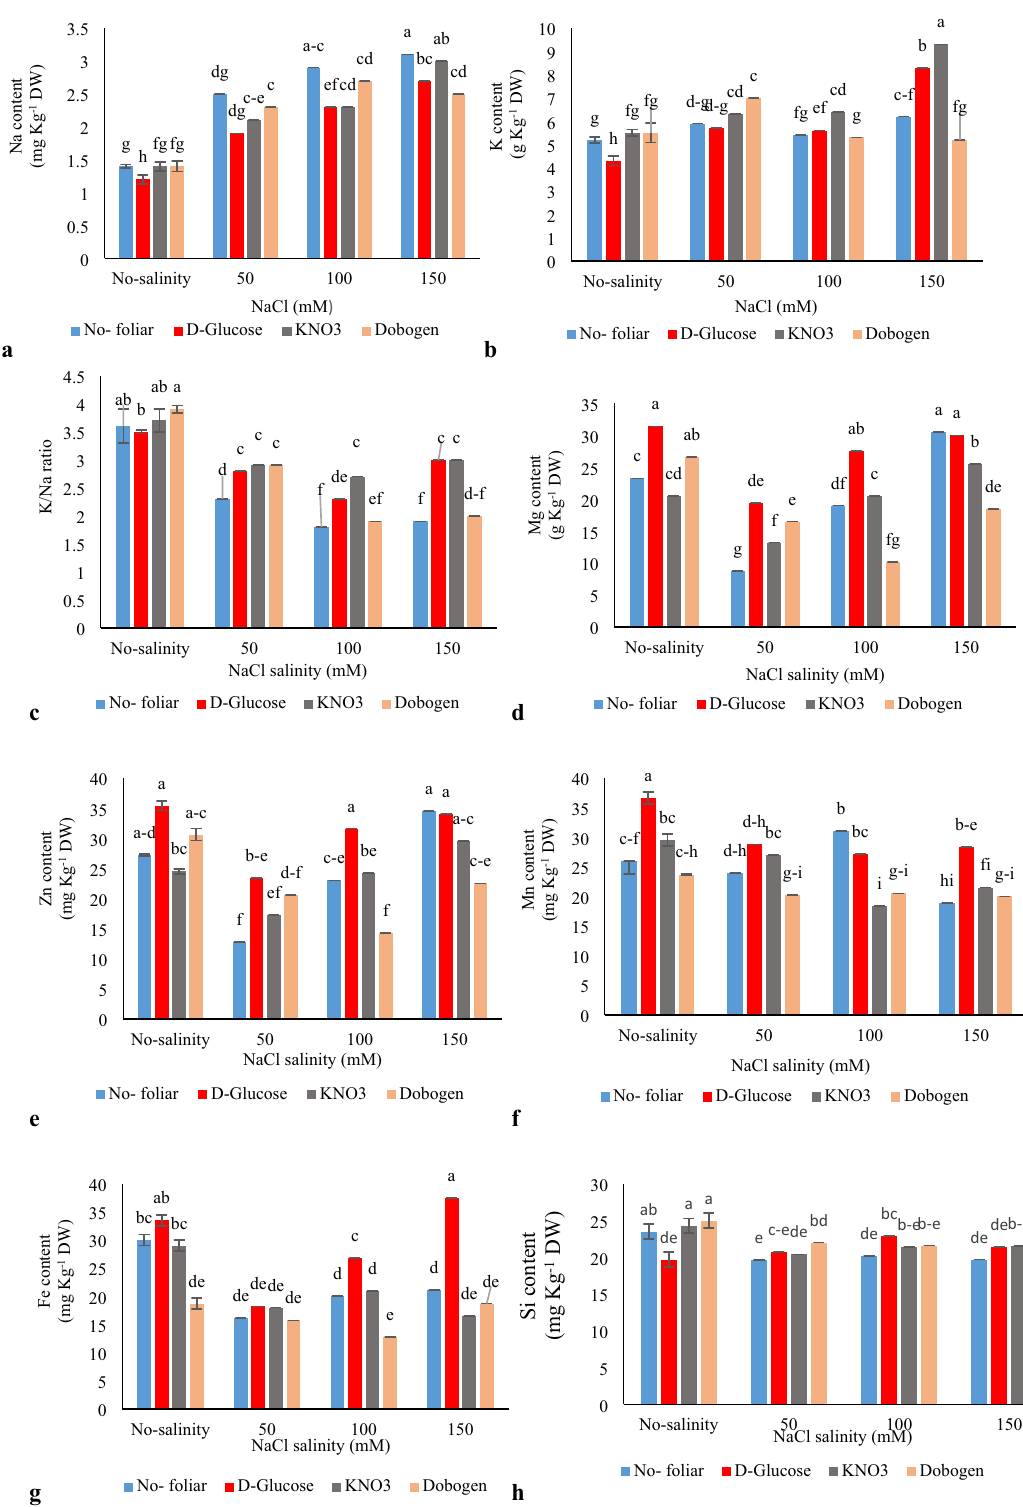
Figure 4. Interaction effect of salinity (0, 50, 100, and 150 mM NaCl) and foliar applications (no-foliar, 2 g L −1 glucose, 2 g L −1 KNO 3, and 2% Dobogen biostimulant) on the elemental content of Tanacetum balsamita plants grown in perlite. Significant differences among treatments are indicated by different Latin letters ( P ≤ 0.01) according to Duncan’s multiple range